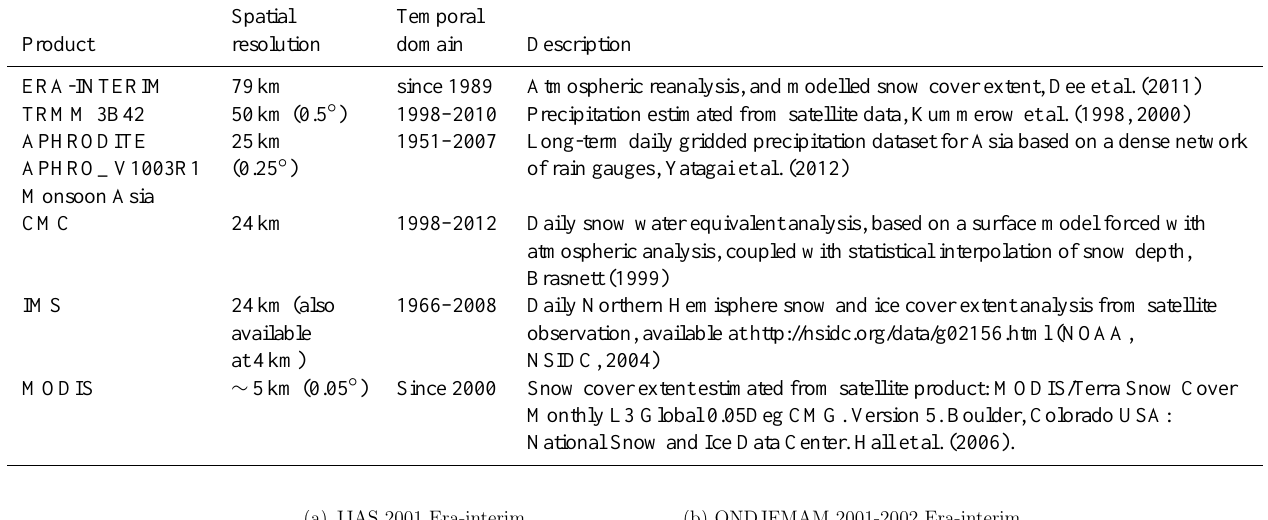
Table 1. Main characteristics of the observational and the reanalysis datasets used for comparisons with model outputs.